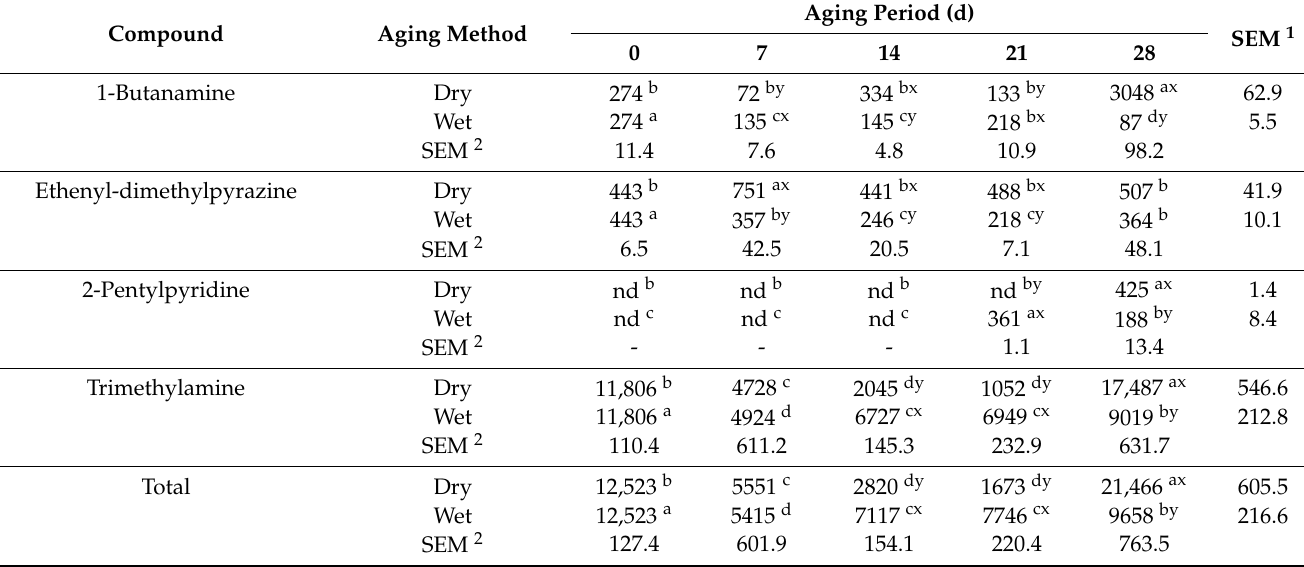
Table 4. Peak area of N-containing compounds in beef during aging with different aging